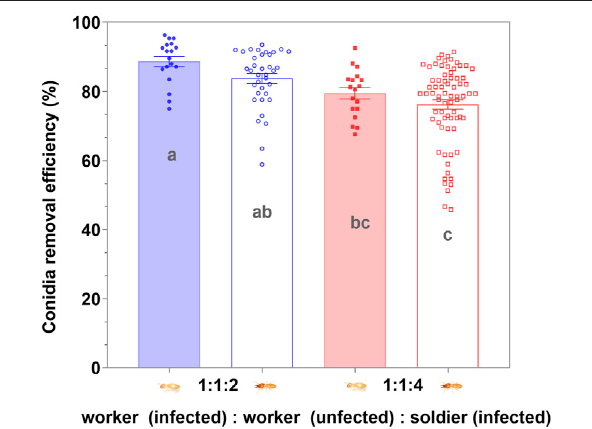
FIGURE 7 | Removal ef fi ciency of the Metarhizium anisopliae conidia on the cuticle by workers post 4 h infection. Data represent the mean ± standard error of the mean (SEM). The numbers in the abscissa represent the numbers of infected workers, uninfected workers, and infected soldiers in each group, respectively. A total of fi ve de fi ned dorsal epicuticle sites of each infected termite (head, thorax, 2nd, 4th, and 6th of abdominal segments) surface were counted for the attachment of conidia. The data columns with different colors symbolized the different soldier and worker compositions. Groups consisting only of workers or soldiers were symbolized by the blue. The data column of the solid color block indicated workers, and the hollow data column indicated the soldier. Different letters indicate the signi fi cant differences among the four sets of data (one-way ANOVAs, LSD, p <